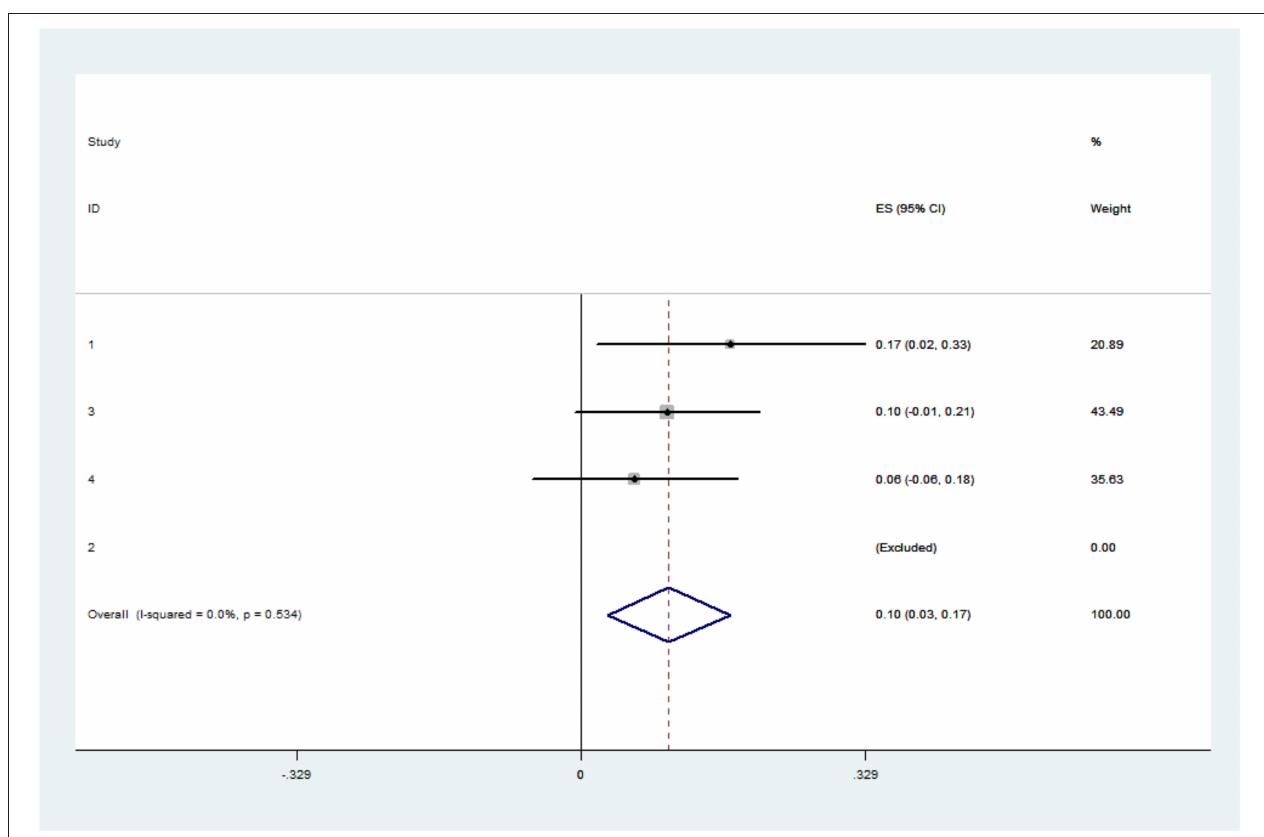
FIGURE 5 | Forest plot presenting the meta-analysis of early re-intervention rate. CI, Confidence intervals; ES, Effect